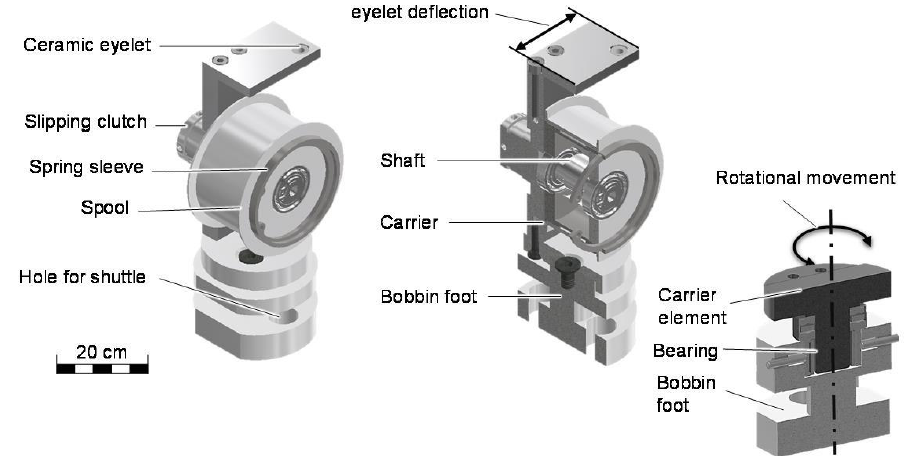
Figure 5. 3D bobbin modifications for better processing of ceramic